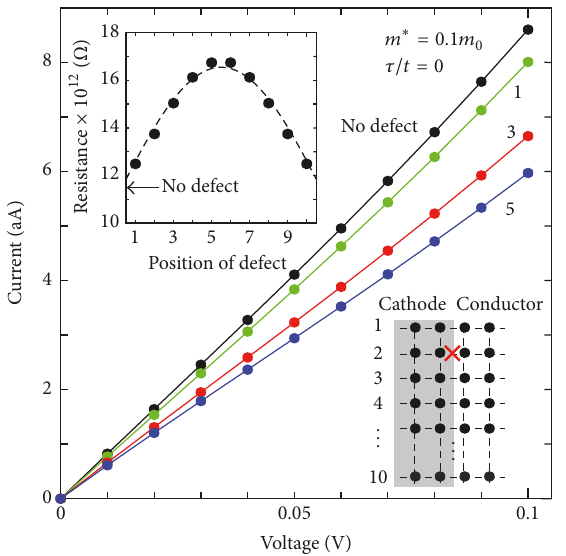
Figure 3: Current-voltage characteristics calculated for 𝜏/𝑡 = 0.0, 0.2, 0.4, 0.6, 0.8, and 1.0. The size of conductor is 𝑁 𝑑 = 20 and 𝑁 𝑤 = 10 and effective mass 𝑚 ∗ = 0.1𝑚 0 . The inset shows the resistance as a function of 𝜏/𝑡